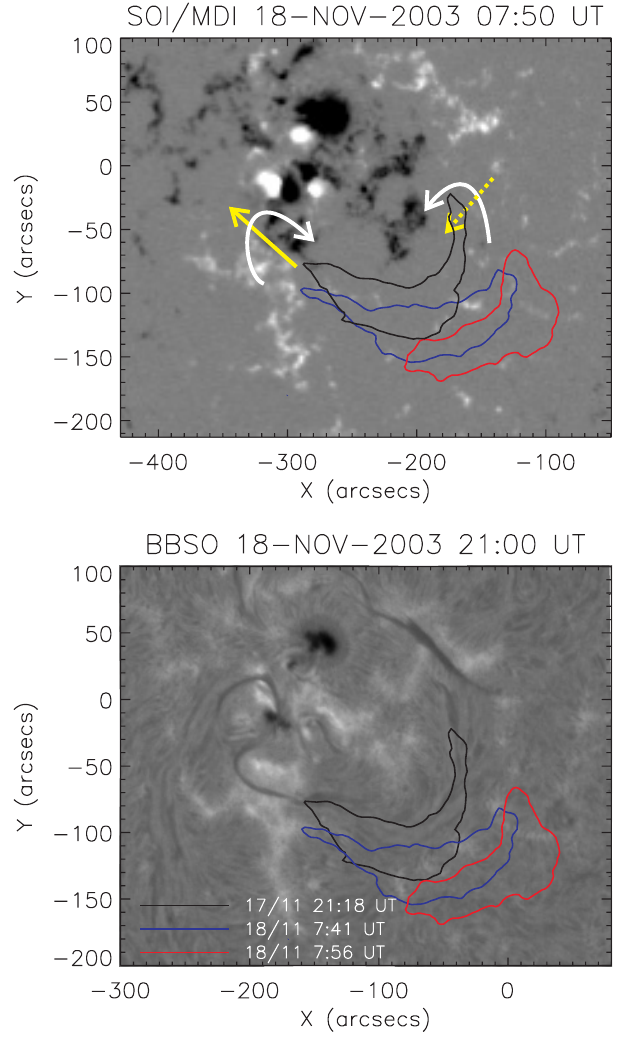
Fig. 4. Top: MDI line-of-sight magnetogram of the active region (white – positive polarity; black – negative polarity) overlaid with contour lines of the U-shaped filament as seen in H α from MLSO the day before (black line) and KSO during the eruption (blue and red lines). White and yellow arrows indicate the leading poloidal and the axial field direction, respectively. Bottom: BBSO H α image after the eruption overlaid with the same contour lines.